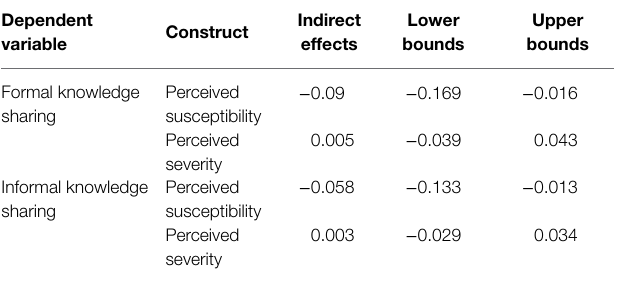
TABLE 6 | Mediate effects